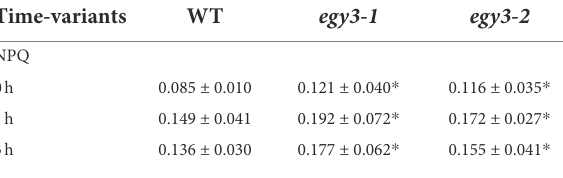
The asterisks indicate statistically significant differences between the WT and individual mutant